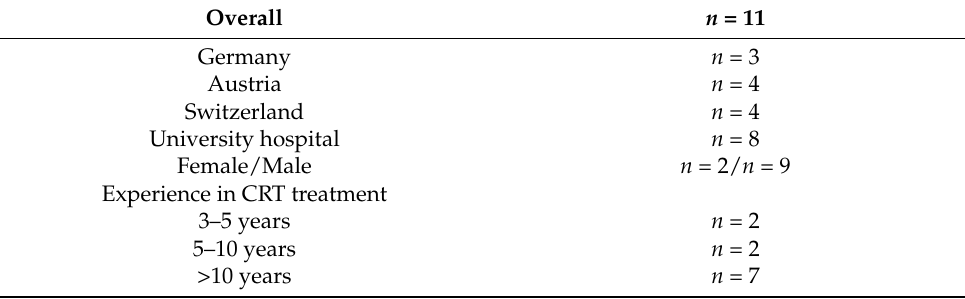
Table 2. Profile of the interviewed